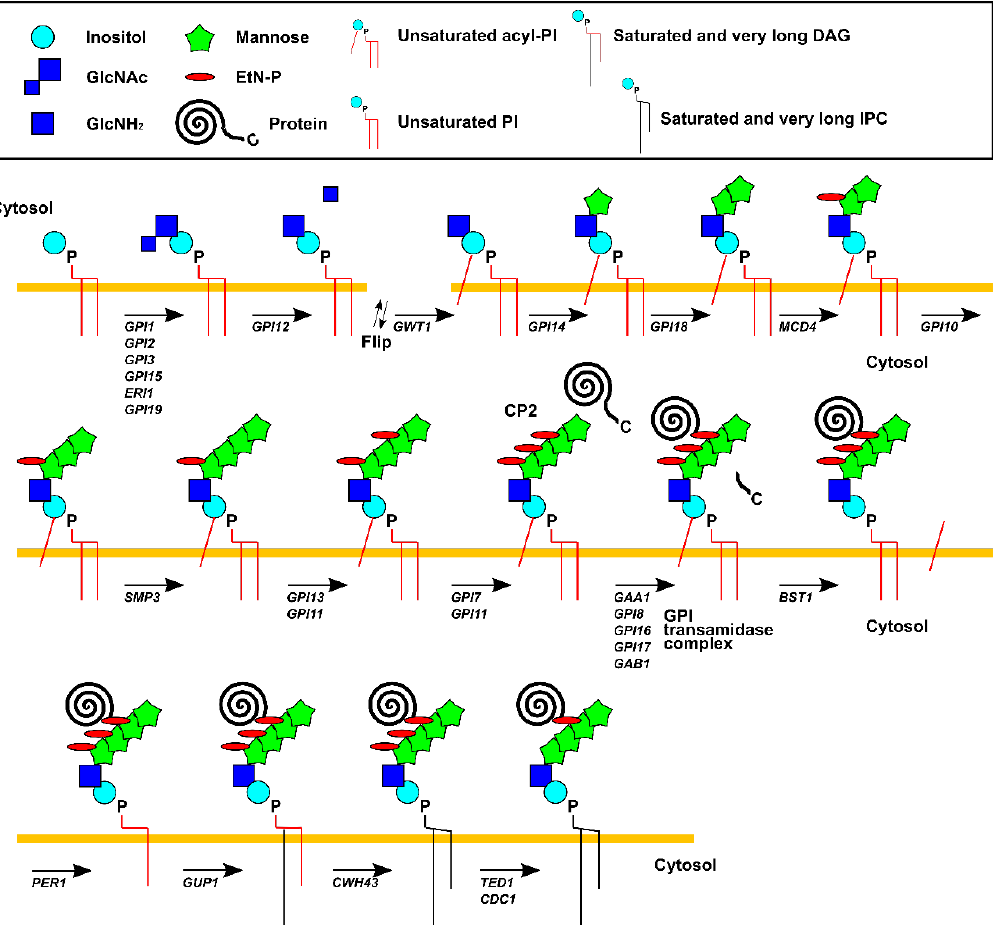
Figure 2. The pathway of GPI (glycosylphosphatidylinositol) biosynthesis in Saccharomyces cerevisiae (see text for de-tail).